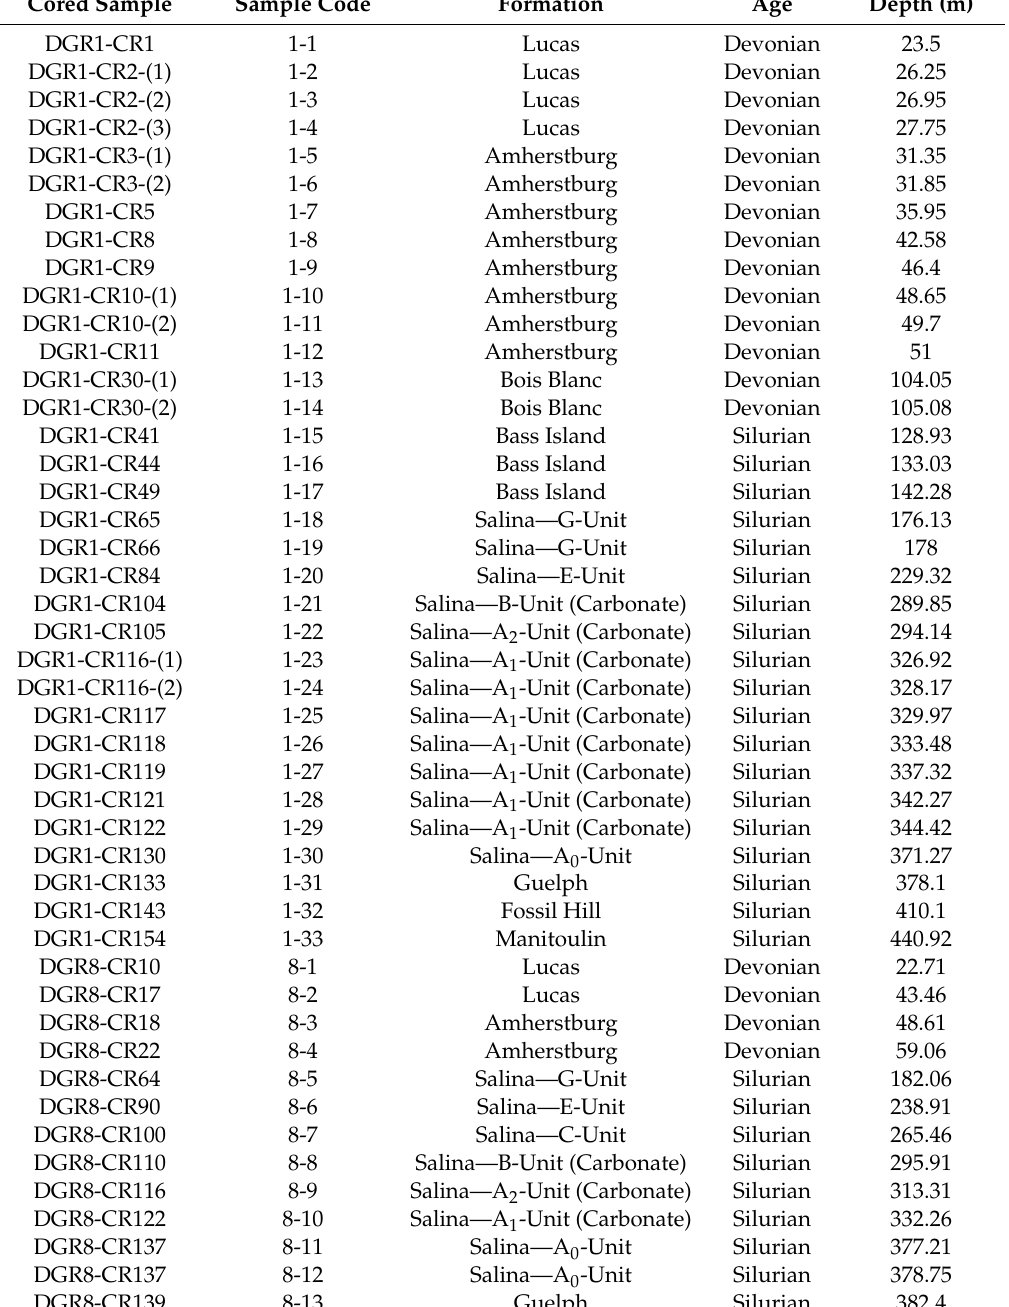
Table 1. Lists of samples collected from the boreholes DGR1 and